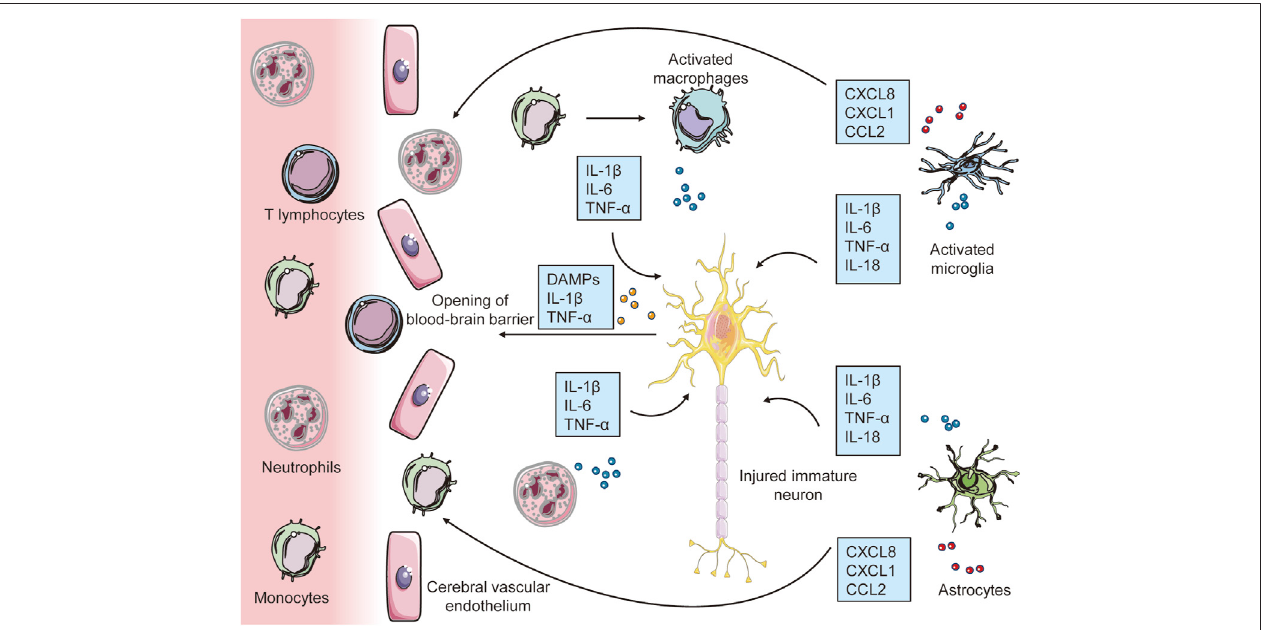
FIGURE 1 | The early in fl ammatory response to hypoxia-ischemia in the developing brain. Immune cells (microglia, macrophages and astrocytes) fi rst sense these damage signals through TLRs and cytokine receptors, which lead to in fl ammatory activation of microglia and astrocytes. By releasing a signi fi cant number of proin fl ammatory cytokines, activated glial cells have a direct neurotoxic effect in initiating damage to immature neurons. Furthermore, the synthesis and release of chemokines by brain resident immune cells and other processes etc, in conjunction with molecular pattern molecules (DAMPs) released by injured neurons, increase blood – brain barrier (BBB) permeability, which leads to the recruitment of peripheral immune cells to the injured brain, contributing to further exacerbation of neuroin fl ammation and subsequent neuronal injury.